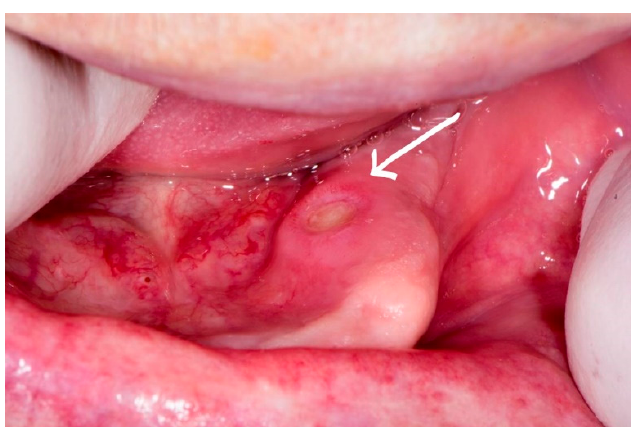
Figure 4. Exposed bone in anterior part of the mandible.